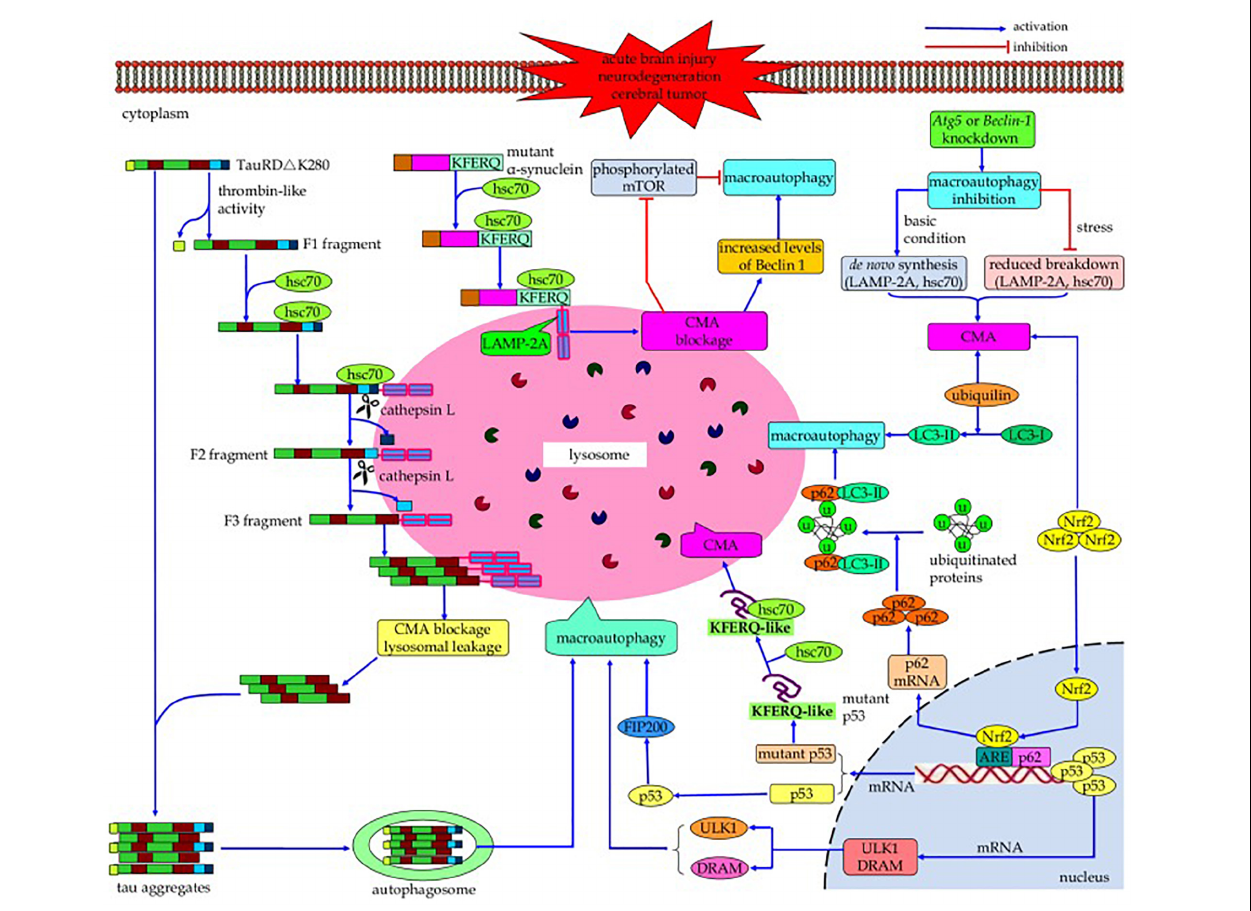
FIGURE 3 | Cross-talk between macroautophagy and CMA. If the activity of one of these autophagic processes is reduced, the activity of the other may increase in a compensatory manner. Continued blockage of CMA by inhibitory RNA targeting of lamp2a results in activation of macroautophagy as indicated by increased levels of Beclin 1; conversely, while nutrient deprivation initially upregulates macroautophagy, continued nutrient deprivation downregulates it with compensatory activation of CMA. However, this compensation may not be bi-directional, and the upregulation of one mechanism may not fully compensate for impairment of the other one. The signaling mechanisms involved in this cross-talk, while poorly understood, may include HSPA8/hsc70, p53, Nrf2, and/or ubiquilin. (Reprinted from Wu et al., 2015).